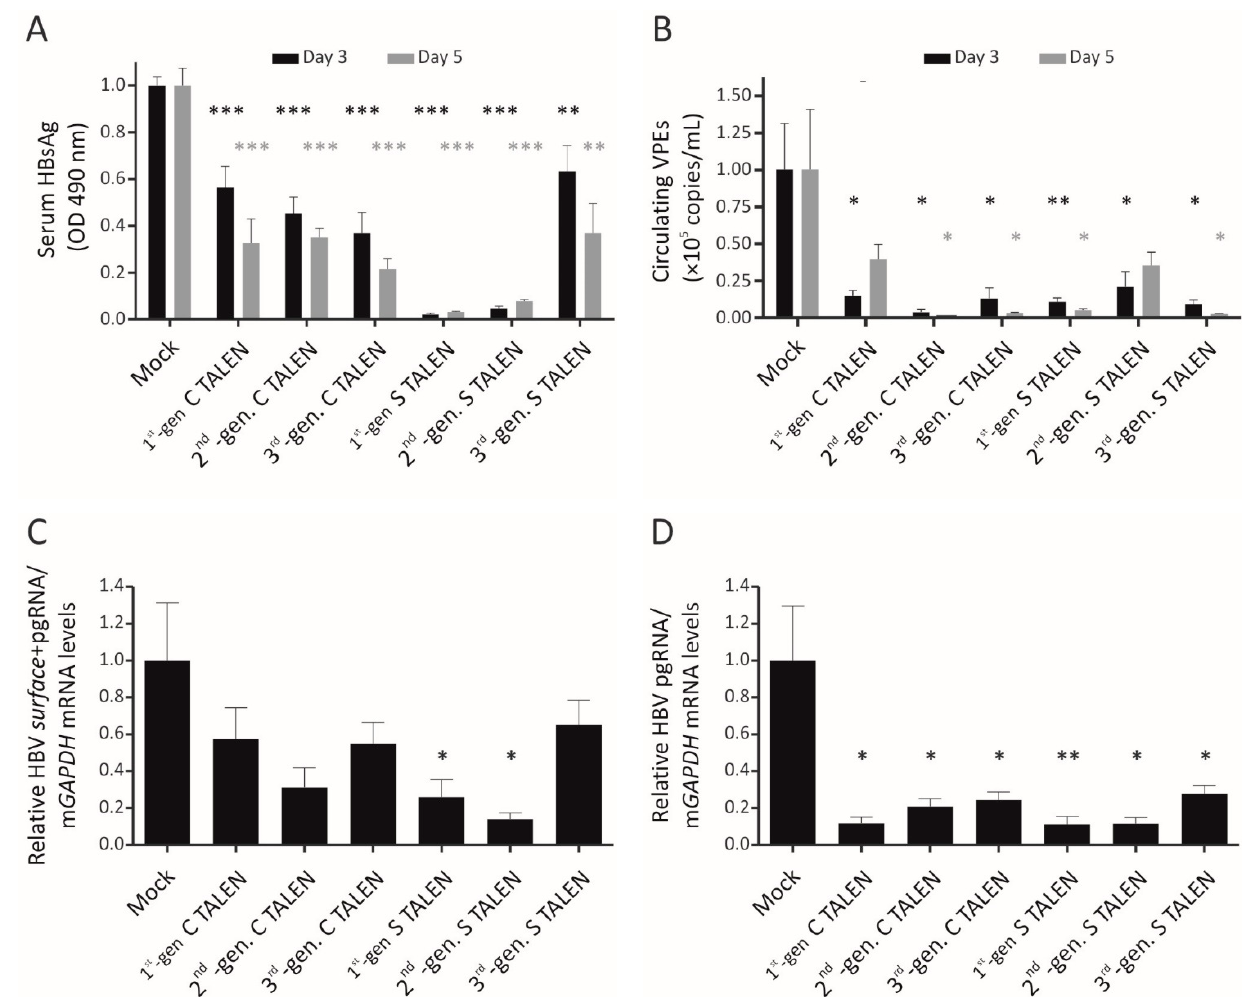
Figure 3. Inhibition of markers of HBV replication in vivo. NMRI mice were hydrodynamically co-injected with pCH-9/3091 and pUC118 or TALEN-encoding plasmids. ( A ) Blood samples were collected on day 3 and day 5 post-injection, and HBsAg levels in the serum were assessed using ELISA. ( B ) Total DNA was extracted from the serum of mice, and qPCR was used to determine the circulating viral particle equivalents (VPEs). ( C , D ) RNA was extracted from murine livers on day 5 post-HDI, and HBV mRNA concentrations were assessed by qPCR. Primers designed against the S and C ORFs were used to measure ( C ) pgRNA and surface mRNA levels or ( D ) pgRNA levels only and relativized to m GAPDH mRNA. Means were calculated and normalized to the mock. n = 7 (mock, 1st-gen S and 3rd-gen S), n = 6 (2nd-gen S and 3rd-gen C), or n = 5 (1st-gen C and 2nd-gen C). Statistical significance was calculated in comparison to the mock (* = p < 0.05; ** = p < 0.001; *** = p <